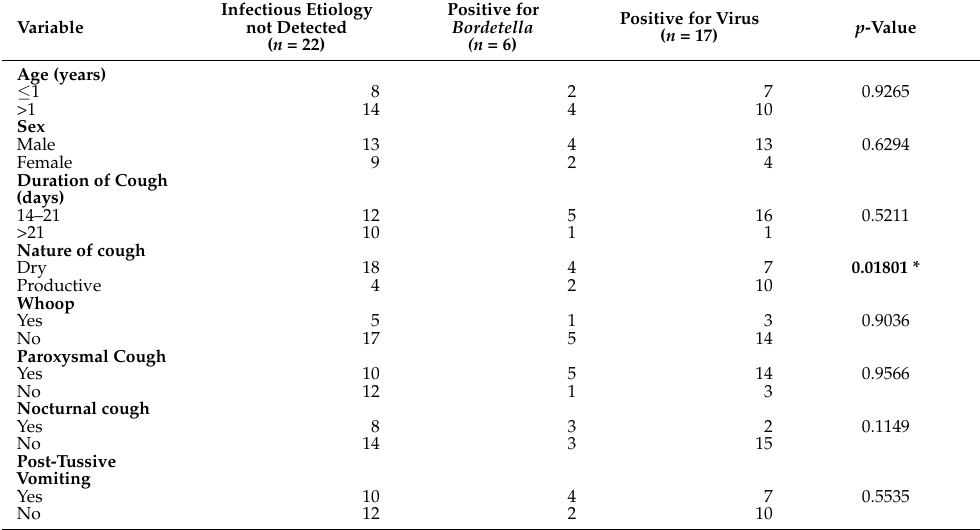
Table 2. Comparison of demographic and the clinical features of the study population.